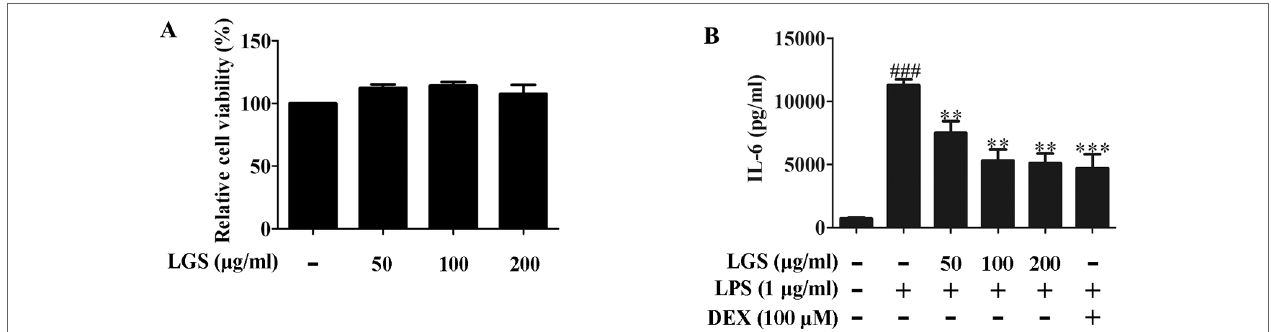
FIGURe 1 | LGS suppresses the release of IL-6 in LPS-induced RAW264.7 cells. (A) LGS (50−200 μg/ml) has no obvious cytotoxicity in RAW264.7 macrophage cells. The cell cytotoxicity of LGS was confirmed by MTT assay. (B) LGS inhibits the production of IL-6 in LPS-induced RAW264.7 cells. Macrophages were cultivated with LGS (200 μg/ml) or dexamethasone (DEX, as a positive control) (100 μM) in the presence of LPS (1 μg/ml) for 24 h. The level of IL-6 in supernatants was analyzed by ELISA. Data are represented as the mean ± SEM of three independent experiments. ### P < 0.001 versus control, ** P < 0.01, *** P < 0.001 versus LPS treatment by one-way ANOVA with Tukey’s